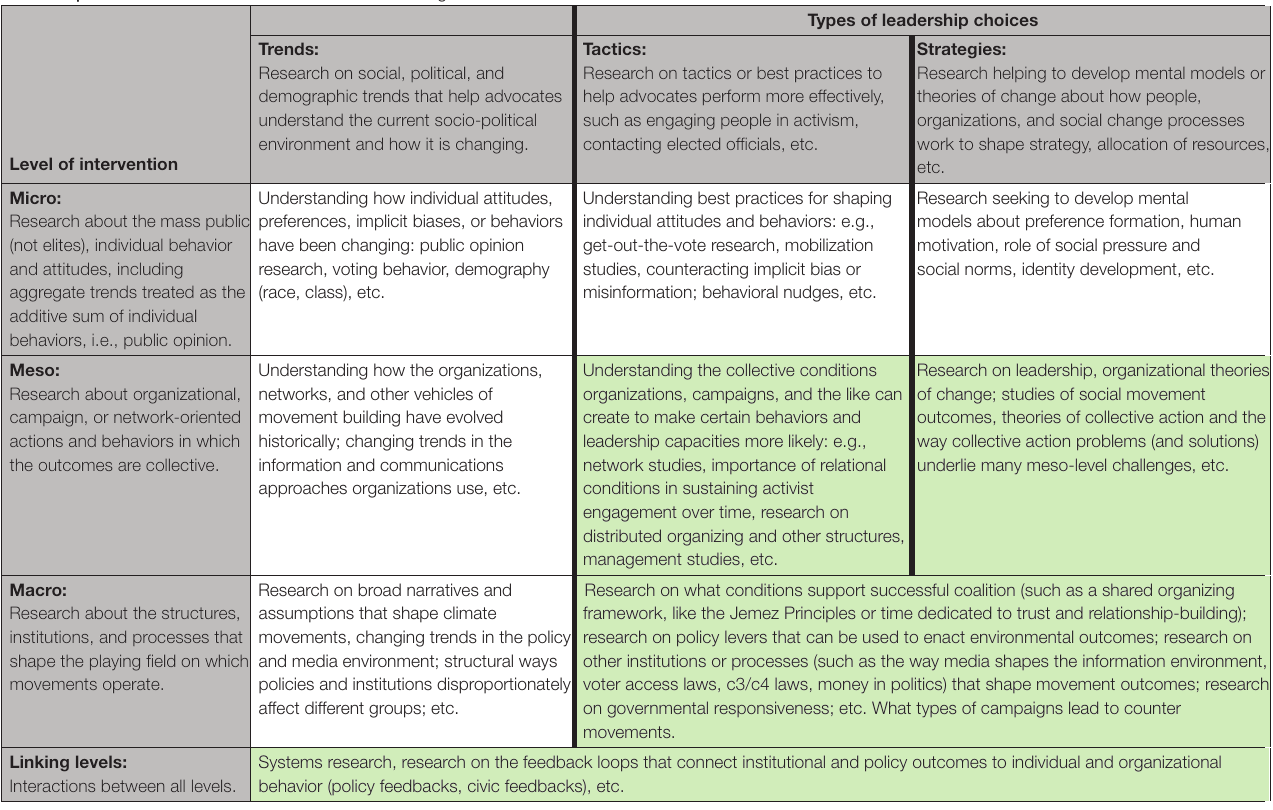
TABLE 1 | A framework for research on